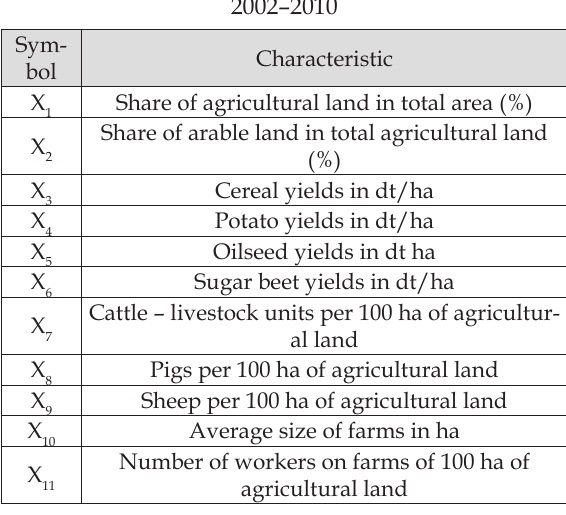
Table 1. Characteristics adopted for the analysis of spatial differences in agricultural development